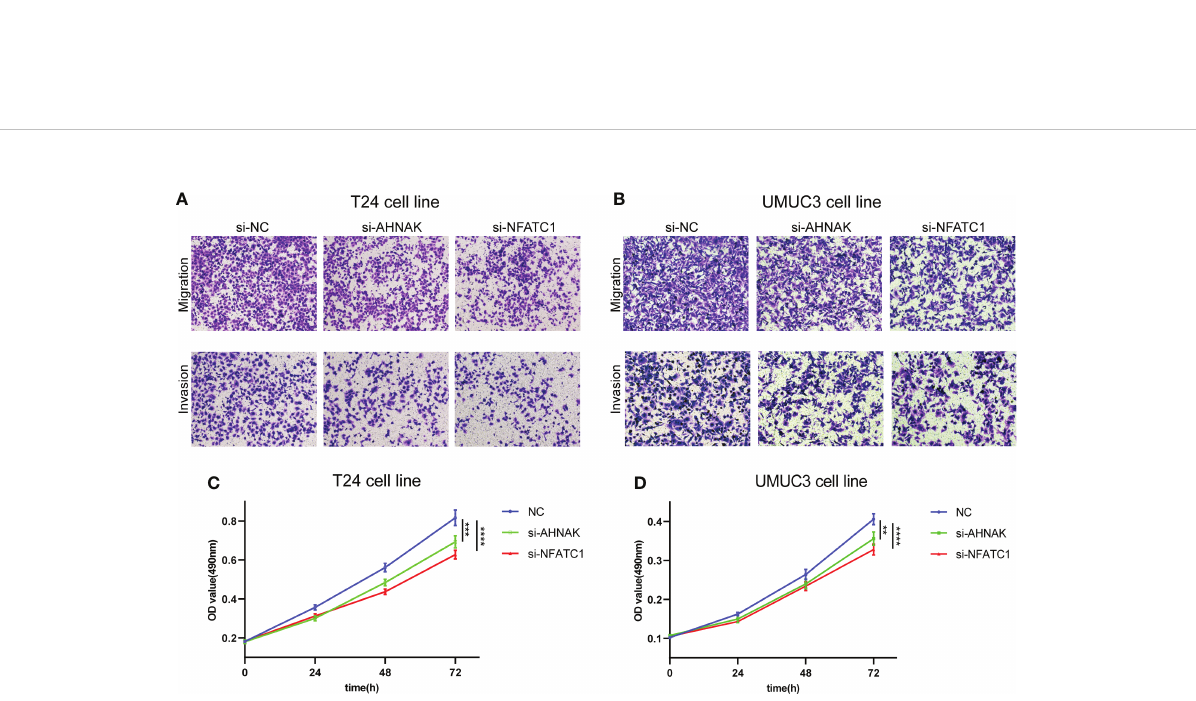
FIGURE 10 AHNAK and NFATC1 increases cell migration, invasion and proliferation in BLCA. (A, B) Transwell migration and invasion assays of T24 and UMUC3 cells transfected with siRNAs against AHNAK and NFATC1 (100× magni fi cation). (C, D) MTT assay of T24 and UMUC3 cells transfected with siRNAs against AHNAK and NFATC1. **p<0.01, ***p<0.001,